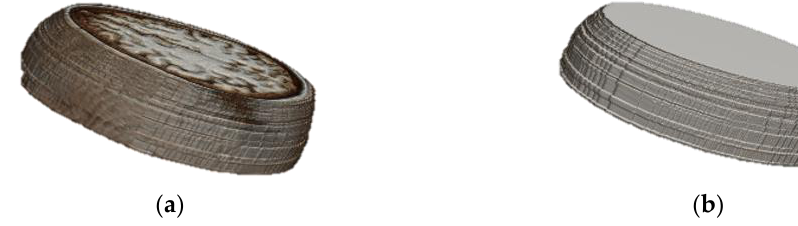
Figure 7. Selected slices from a 3-D volume of brain MRIs. ( a ) Selected slices based on semi-axes, and ( b ) extracted elliptical area from slices.